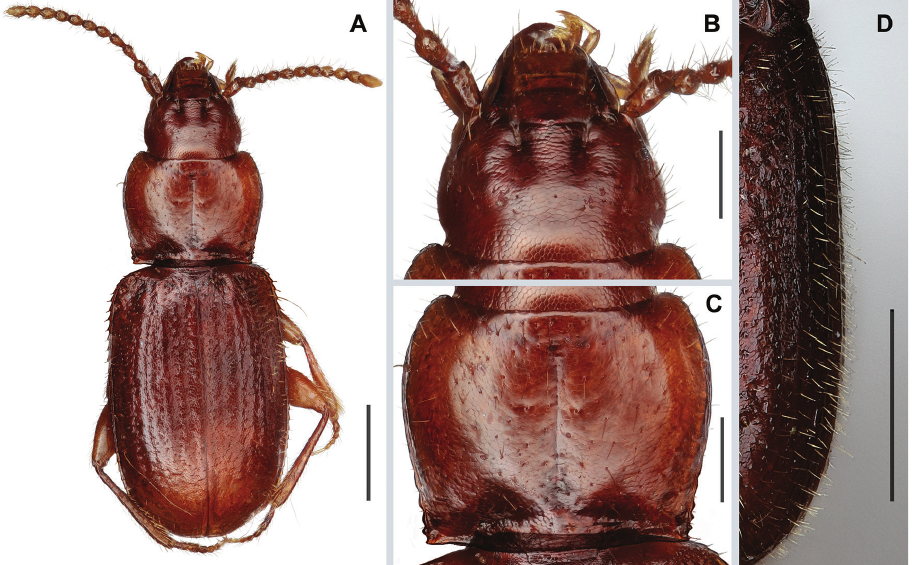
Figure 3. Digital images of external features of Anillinus relictus sp. nov. (male, E of Oneonta, Blount County, Alabama) A habitus, dorsal aspect B head, dorsal aspect C pronotum, dorsal aspect D elytral vestiture, left lateral aspect. Scale bars: 0.5 mm ( A, D ); 0.2 mm ( B, C ).